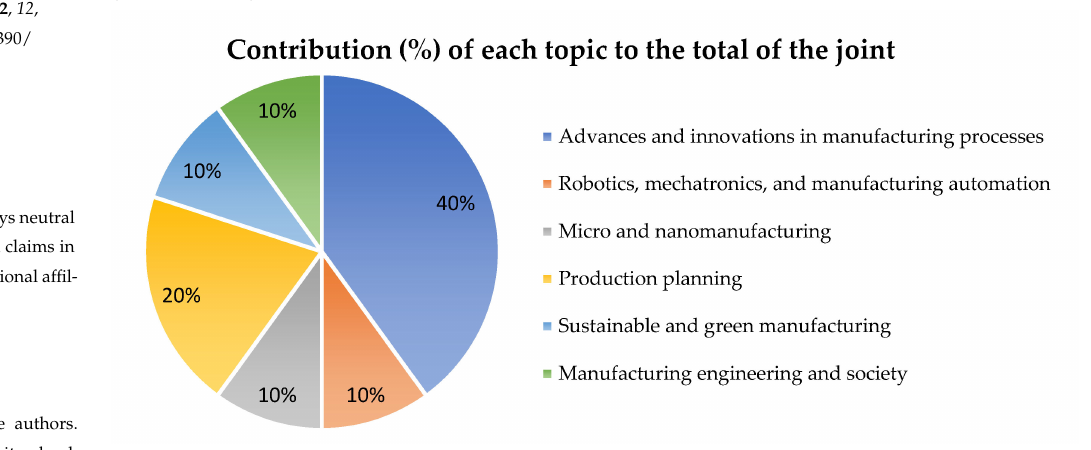
Figure 1. Contribution (%) of each topic to the joint Special Issue as a